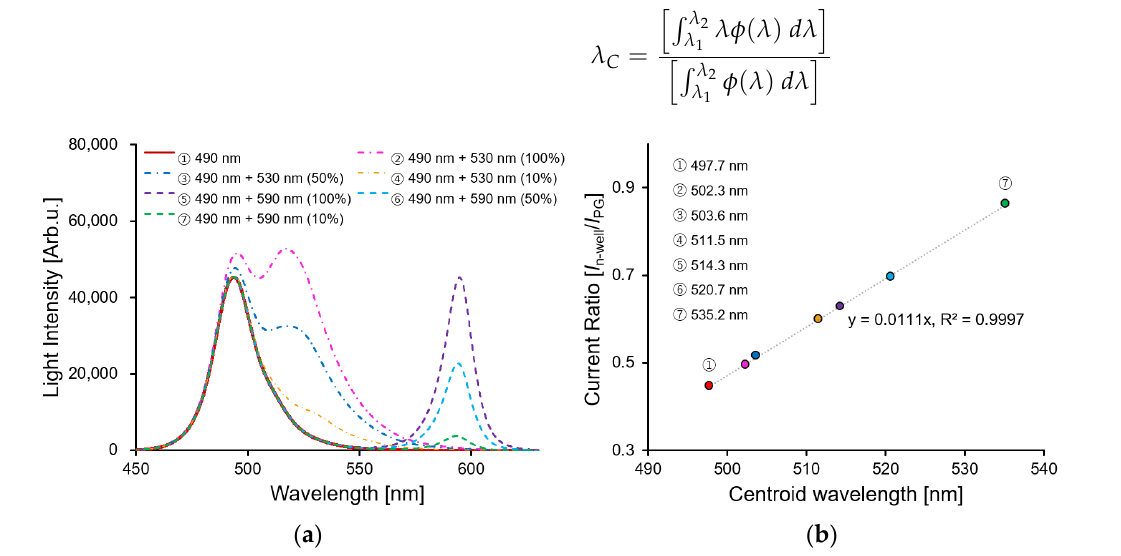
Figure 8. ( a ) Spectral characteristics by LED light source 490 nm, 490 + 530 nm, and 490 + 590 nm. The 490, 530, and 590 nm light intensities are 16.98, 13.44, and 22.66 μ W/cm 2 , respectively. The 530, and 590 nm LED light sources changed the light intensity by 100, 50, and 10%; ( b ) the relationship between centroid wavelength by spectrum and current ratio.